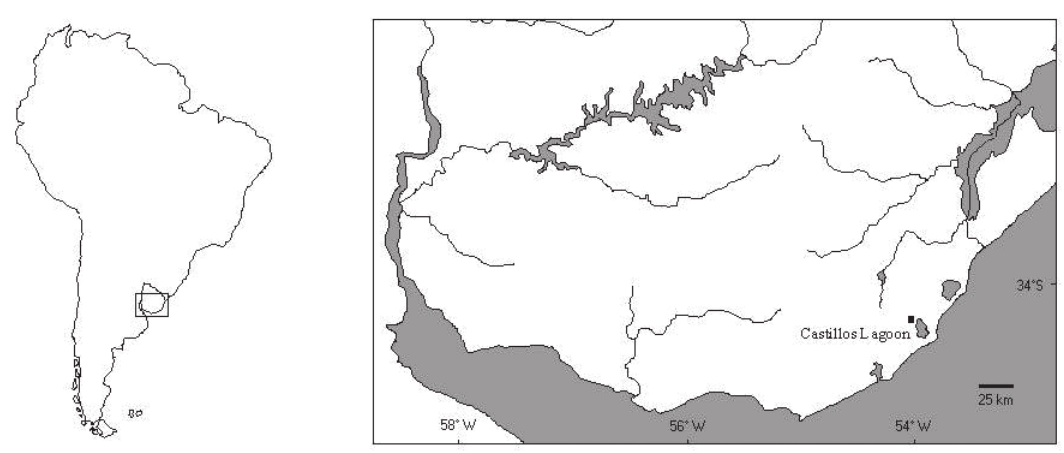
Fig. 1. Map of the study site area. The sampled temporary pools are located in the Castillos Lagoon Basin, about 60 km from Brazilian